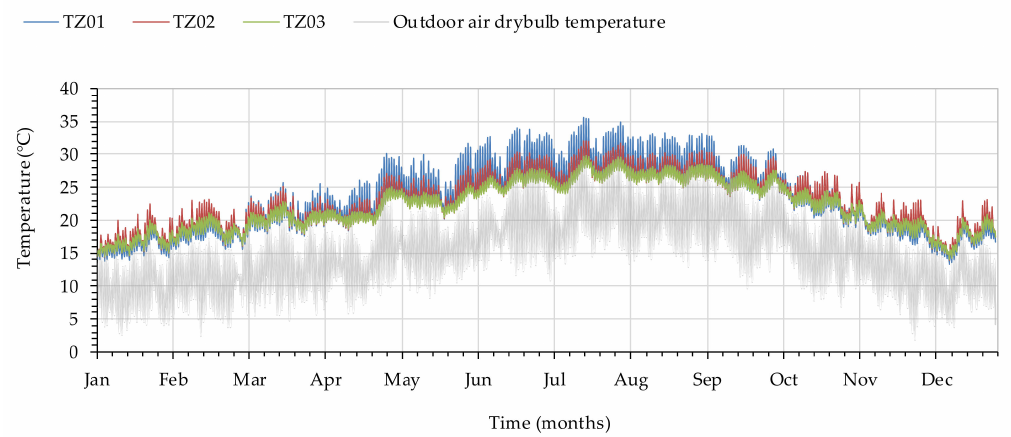
Figure 10. Annual temperature of the reference building (indoor and outdoor air dry-bulb